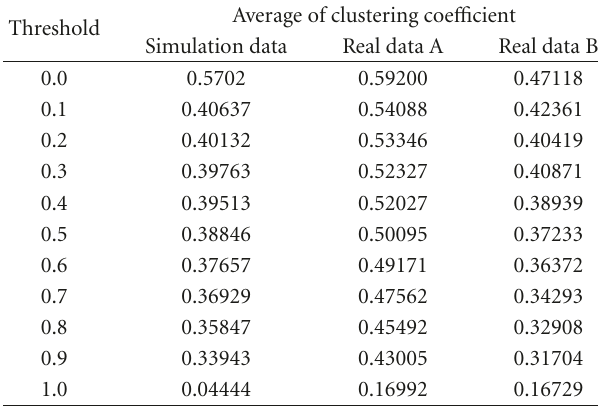
Table 1: Average of clustering coe ffi cient versus threshold. Average of clustering coe ffi Threshold